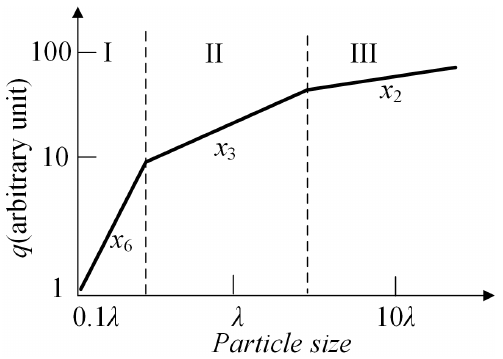
Figure 1. The general relationship between scattering intensity and particle